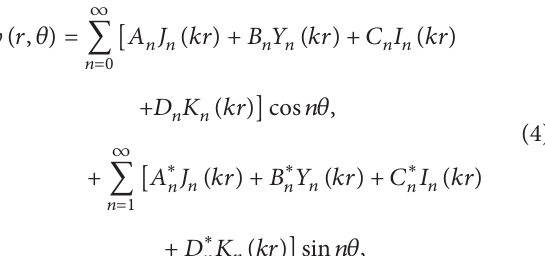
spring constants at 𝑟 = 𝑎 and 𝑏 ( 𝜃 = 0 and 𝜙 ),